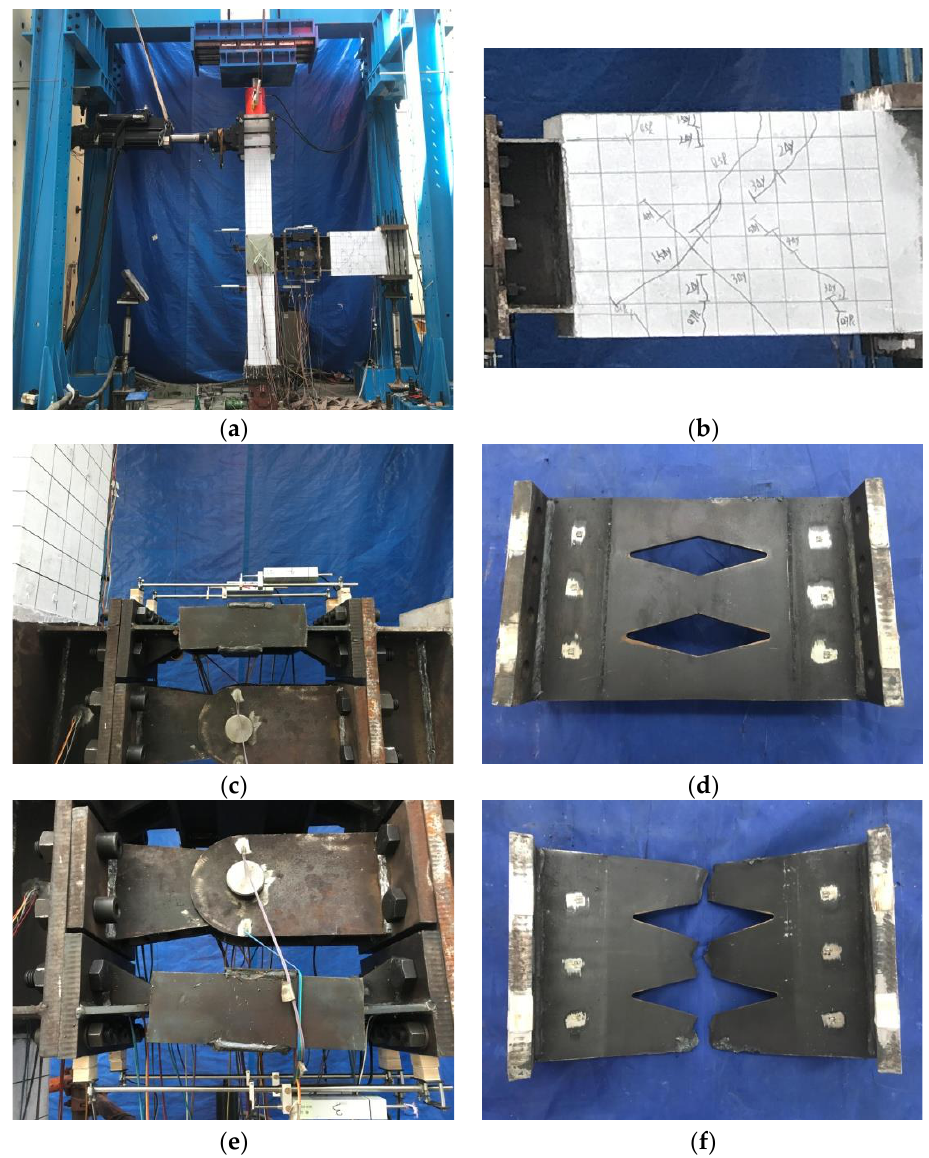
Figure 7. ( a ) The failure mode of the precast replaceable beam-to-column joint; ( b ) crack development in concrete; ( c ) failure mode of the upper connector; ( d ) failure mode of the upper steel plate; ( e ) failure mode of the lower connector; ( f ) failure mode of the lower steel